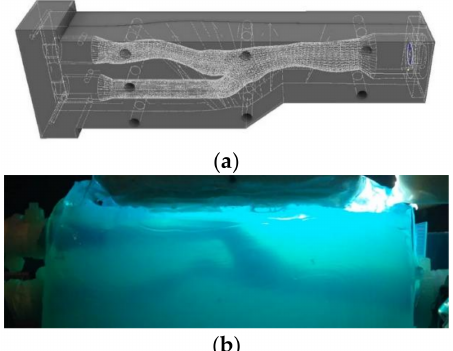
Figure 1. ( a ) 3D CAD-based mold of a realistic patient-specific carotid artery and ( b ) Polyvinyl alcohol phantom casted in a surrounding